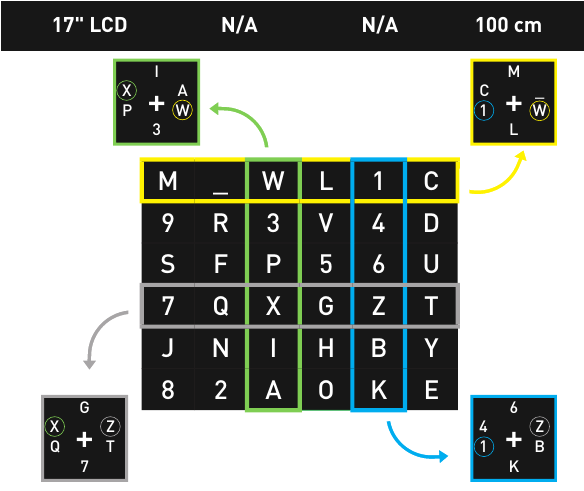
Figure 7. The GeoSpell as discussed in Aloise et al. [78], showing the group organization concept. The figure is modified from the original source